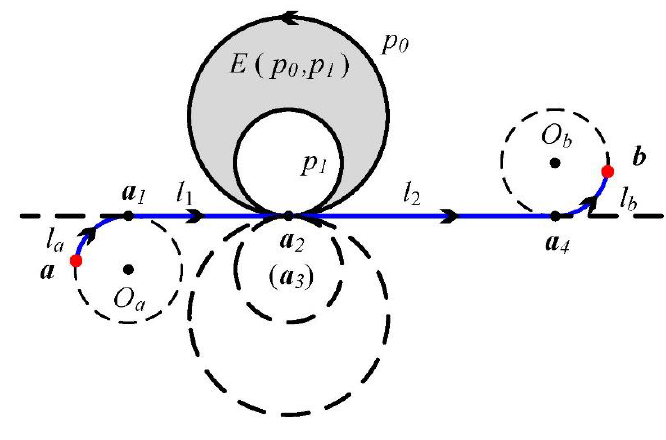
Figure 7. Path homotopy 2.